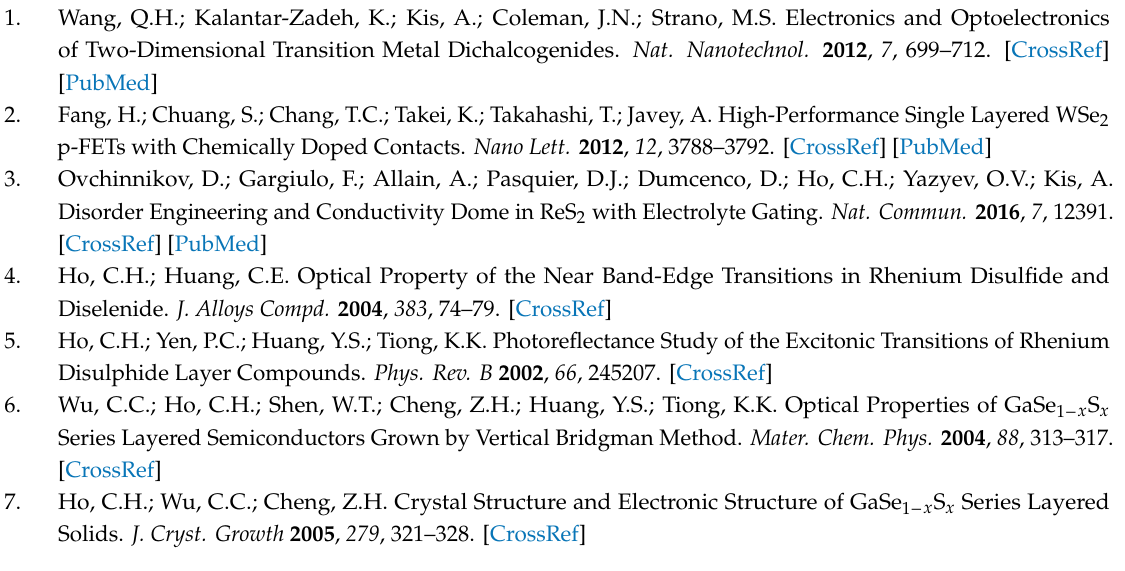
Figure S1: Crystal morphology of c -plane layered ZrS 2 − x Se x (x = 0, 1, and 2). Figure S2: Energy Dispersive X-ray (EDX) analysis of ZrS 2 − x Se x (x = 0, 1, and 2). Figure S3: Temperature-dependent Raman spectra of ZrS 2 , ZrSe 2 , and ZrSSe. Figure S4: The XPS spectra of (a) Zr 3 d 3 / 2 and Zr 3 d 5 / 2 , (b) S 2 p 3 / 2 and S 2 p 1 / 2 , and (c) Se 3 d 5 / 2 and Se 3 d 3 / 2 in ZrS 2 − x Se x (x = 0, 1, and 2). Table S1: The comparison of lattice constants of ZrS 2 − x Se x obtained by XRD and TEM measurements. Table S2: Resistivity and Hall measurement results at 300